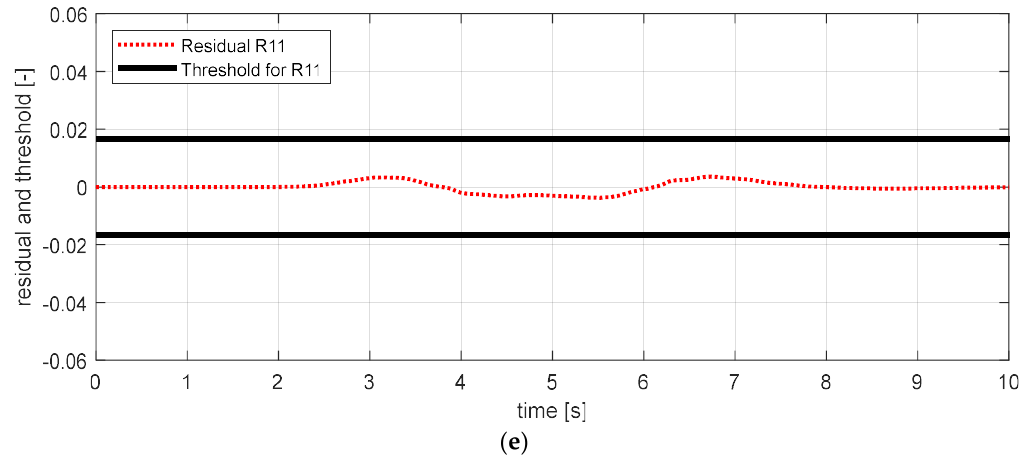
Figure 21. FDI simulation result for lateral acceleration sensor (normal). ( a ) Residual 7 and threshold; ( b ) residual 8 and threshold; ( c ) residual 9 and threshold; ( d ) residual 10 and threshold; ( e ) residual 11 and threshold.